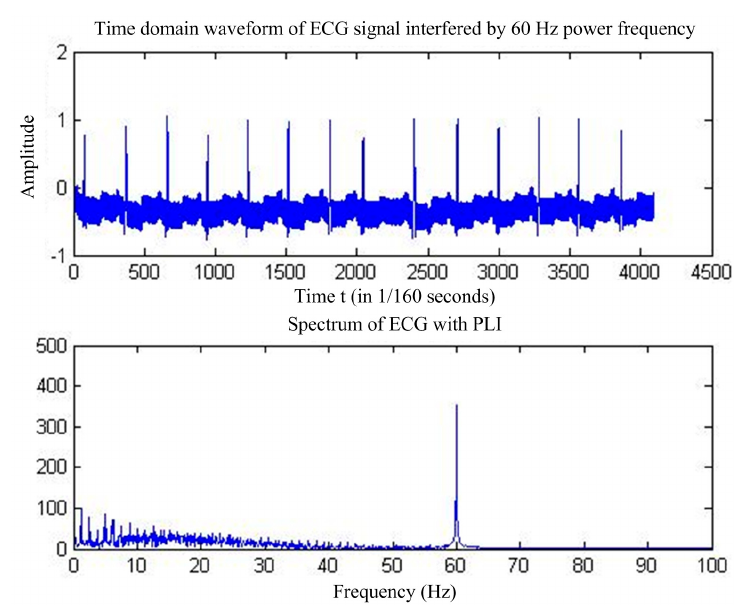
Figure 1. ECG signal with PLI.